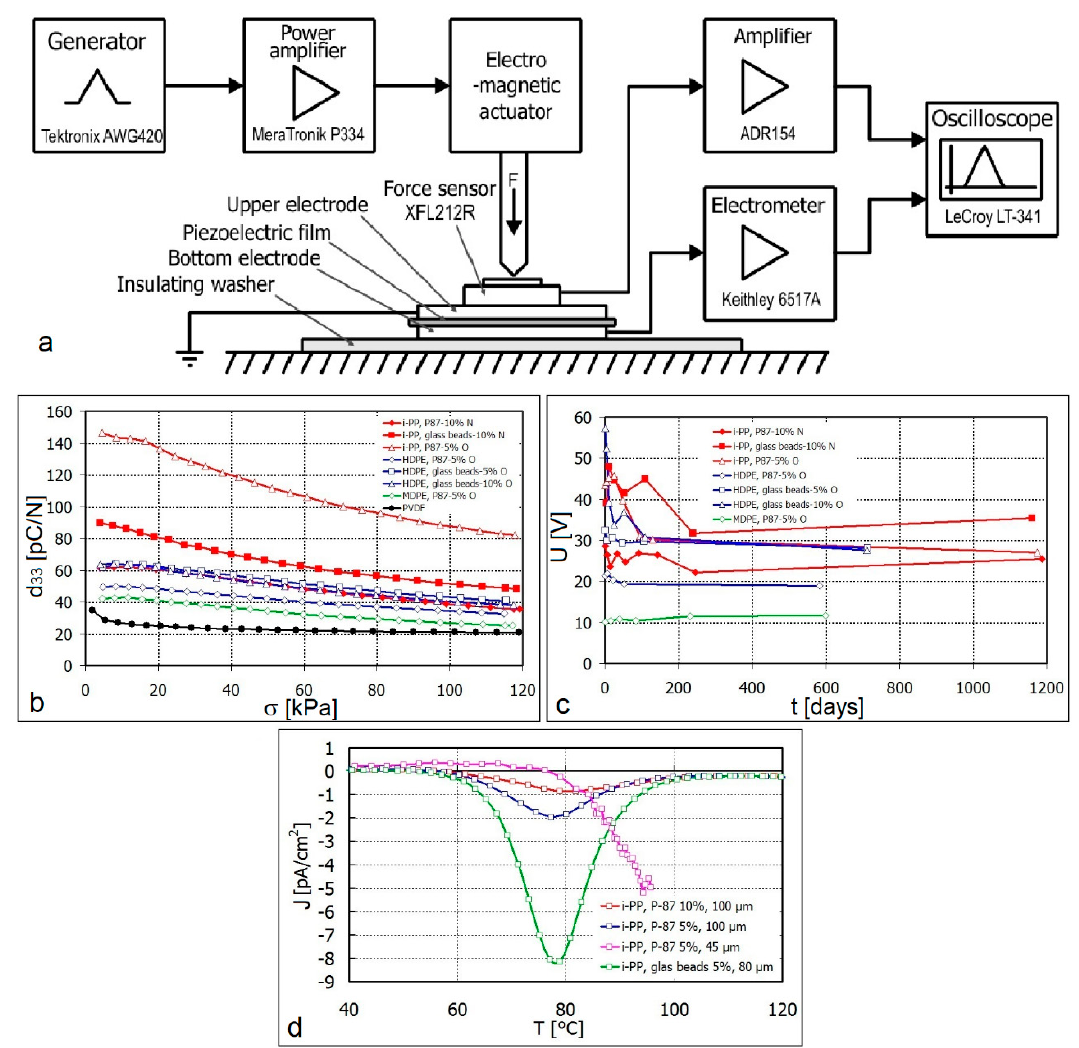
Figure 3. ( a ) Scheme of the device for measuring piezoelectric signals; ( b ) dependence of the d 33 coefficient vs. mechanical stress; ( c ) dependence of the piezoelectric voltage on the storing time of electrets in room temperature (RT); ( d ) dependence of the density of depolarization currents (J) vs. temperature for the selected electrets.